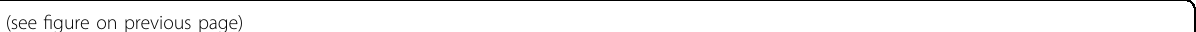
Fig. 3 DNA binding is required for CENP-N centromere localization and function in mitosis. a Representative immuno fl uorescence montage of HeLa cells expressing GFP-CENP-N wild type and DNA binding-de fi cient mutants. Scale bar, 10 µm. Note that K270 and K296 binding to DNA determines CENP-N localization to centromere in mitosis. b Statistical analyses of centromere localization ef fi cacy of CENP-N wild type and mutants. Data present means ± s.e.m. from three independent experiments of 30 cells for each group. Ordinary one-way ANOVA followed by Tukey ’ s post hoc test was used to determine statistical signi fi cance. **** p < 0.0001; ns, not signi fi cant. c Real-time imaging of HeLa cells with chromosome marked by H2B-mCherry and GFP-tagged CENP-N wild type and 2E mutant in the absence of endogenous CENP-N. Note that 2E mutant caused mitotic arrest with chromosome alignment defect. Scale bar, 10 µm. d Quanti fi cation of mitotic phenotypes in cells expressing CENP-N 2E mutant after induction of endogenous CENP-N knockout as in c . Data present means ± s.e.m. from three independent experiments (Control, n = 69; CENP-N KO, n = 68; N- KO + N-WT, n = 68; N-KO + N-2E, n = 68). Ordinary one-way ANOVA followed by Tukey ’ s post hoc test was used to determine statistical signi fi cance. **** p < 0.0001. e Representative immuno fl uorescence montage of HeLa cells expressing GFP-CENP-N wild type and 2E mutant and stained